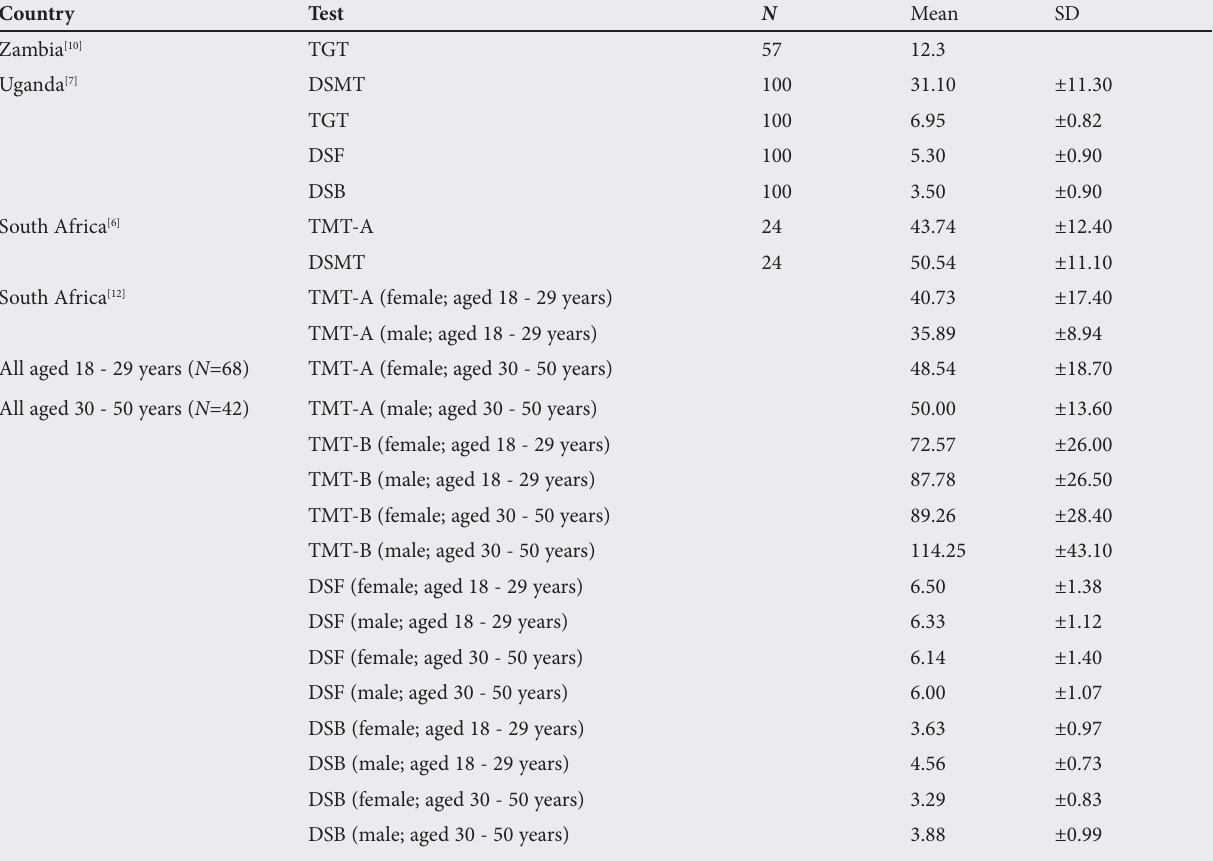
Table 2. Scores for TGT, DSMT, TMT and DS conducted among HIV-negative respondents in East and Southern Africa Country Test N Mean SD Zambia [10] TGT 57 Uganda [7] DSMT